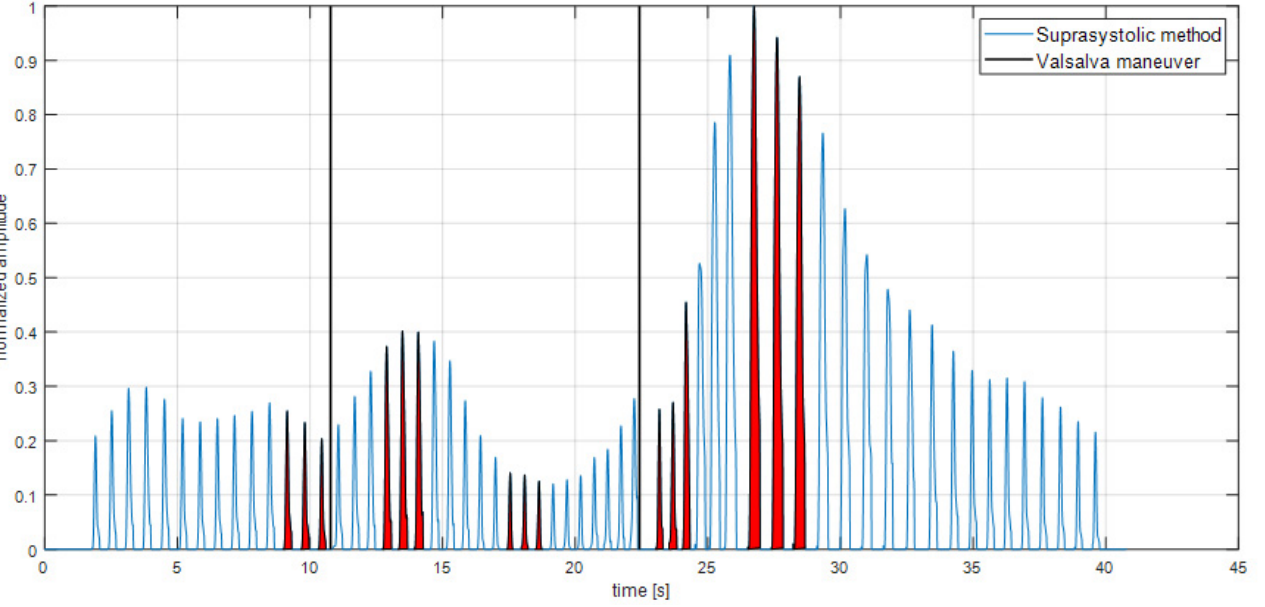
Figure 3. Calculation of OCCI. For the average percent change of OCCI was used three-point moving average and found max during maneuver, min and the value of the resting state before. The highlighted peaks meet these findings. In total, compared to the resting state, there was 8% increase, 19% decrease and percent change during maneuver (max/min) was 35%. The reaction after the maneuver was also the object of research however, it had a limitation in a holding the suprasystolic pressure after arising of the pressure in brachial artery.